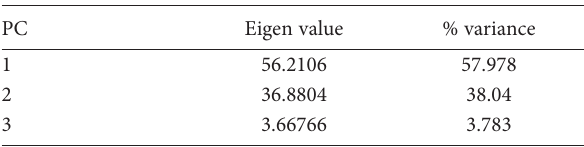
Table 5. Principal component analysis of Lathyrus taxa showing the eigen values of total variance.